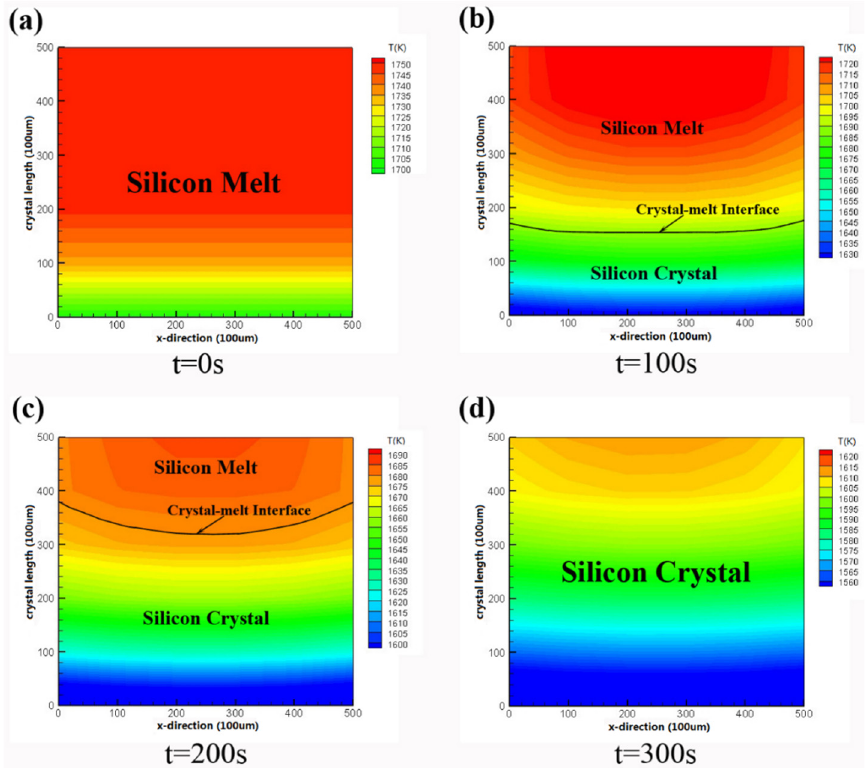
Figure 3. Temperature distribution and crystal-melt interface position with heat transfer coefficient